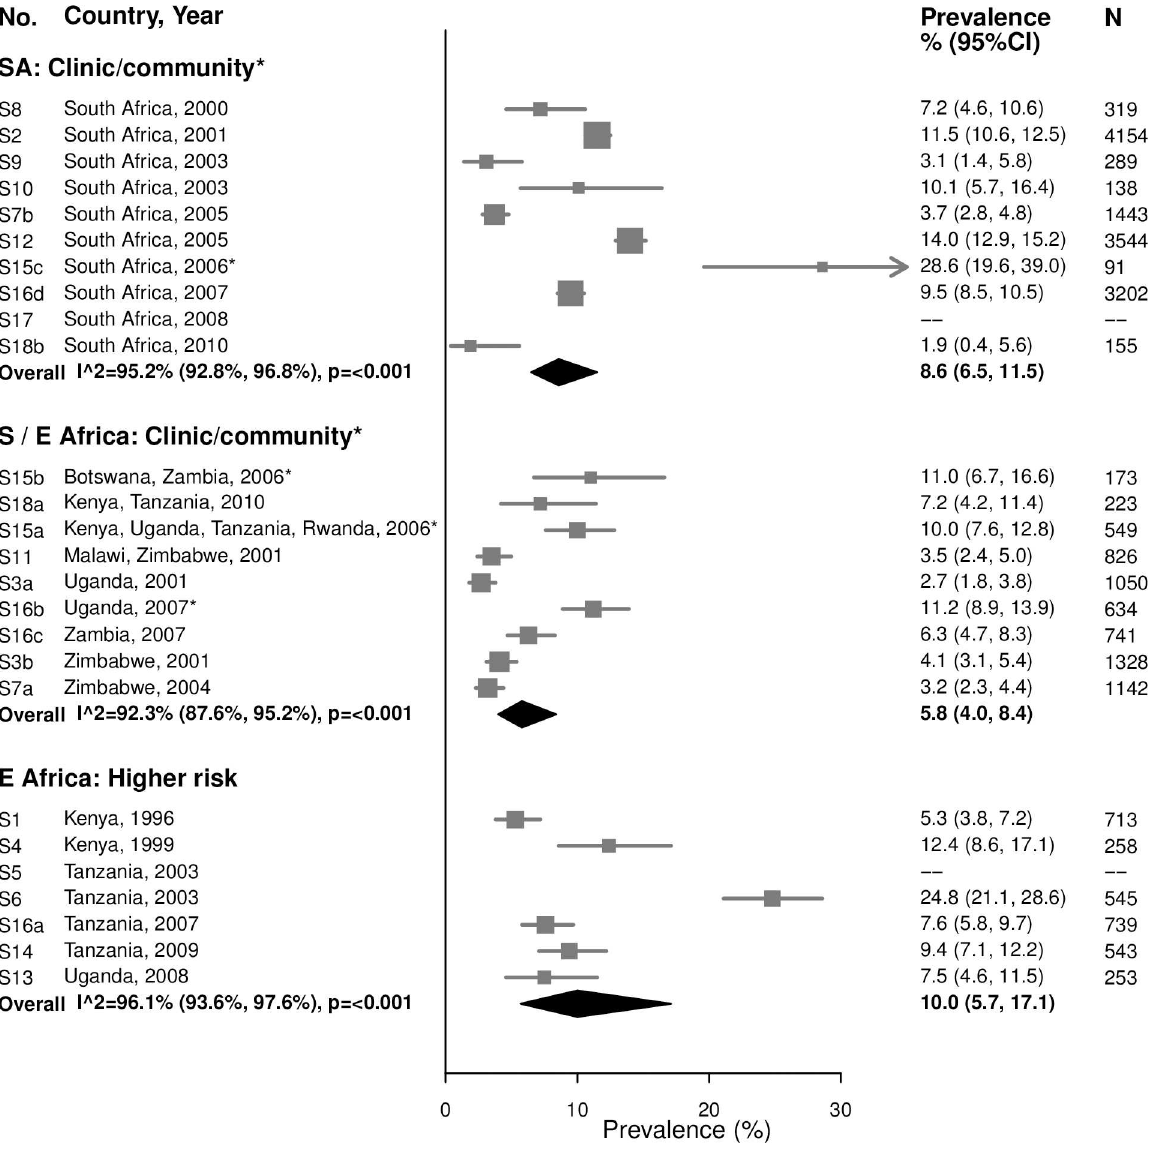
Fig 10. Trichomoniasis prevalence among 25–49-year-olds. The area of the marker is proportional to the square root of the sample size. Studies with no estimate presented did not meet the inclusion criteria for this infection and age group. Year presented is the median year that baseline data were collected during the study. (cid:3) Includes studies of HIV-discordant couples. E Africa, Eastern Africa; SA, South Africa; S/E Africa, Southern and Eastern